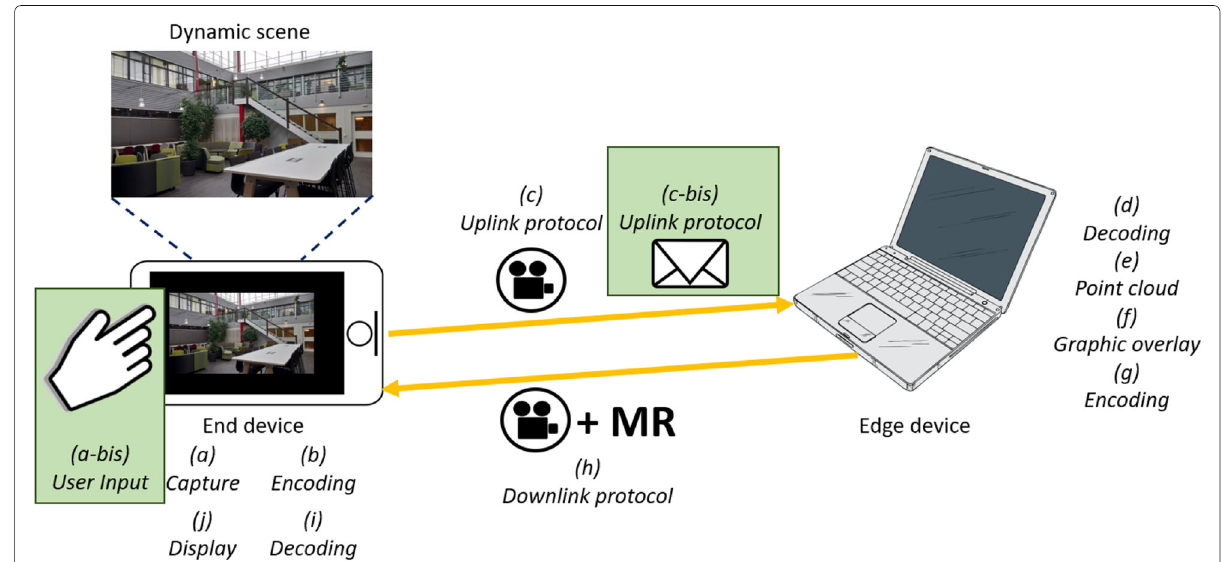
Fig. 3 MR scenario used in the